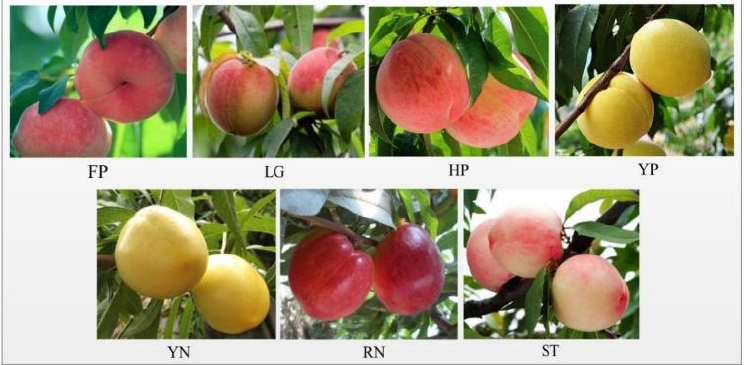
Figure 1. Photos of peaches. Flat peach (FP), liguang peach (LG), honey peach (HP), yellow peach (YP), yellow nectarine (YN), red nectarine (RN) and shoutao (ST) from shihezi, Xinjiang. Every batch of samples (60) was taken from the upper, middle, and lower positions of each tree.